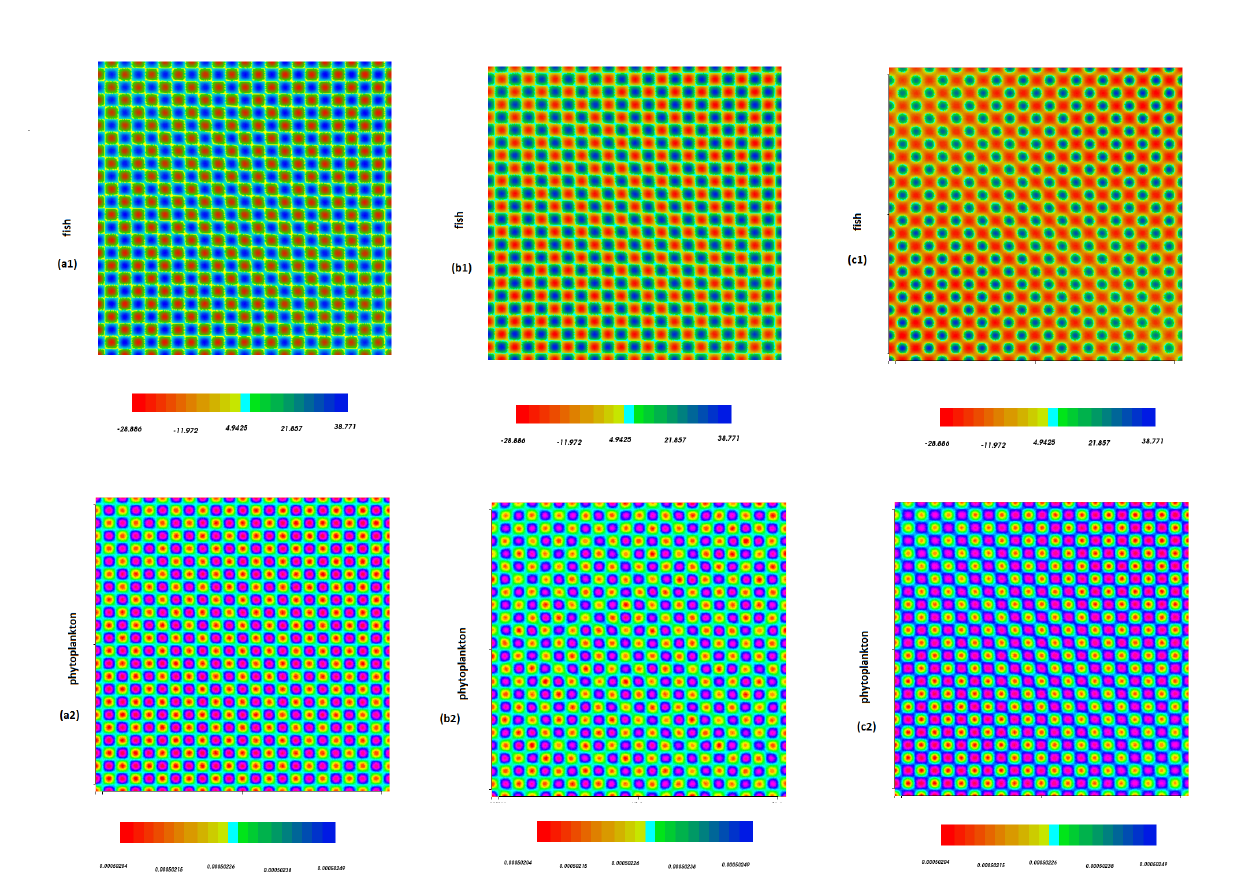
Figure 2. Pattern formation of two dimensional space: fish [first line] and phytoplankton [second line] population density of the model system (4). The diffusion coefficient values are δ 0 = 0.3, δ 1 = 0.1 δ 2 = − 0.2 δ 3 = 0.4. Spatial patterns are obtained at different times: for plot t = 10 ( a 1; a 2 ) ; t = 40 ( b 1; b 2 ) ; t = 200 ( c 1; c 2 ) .